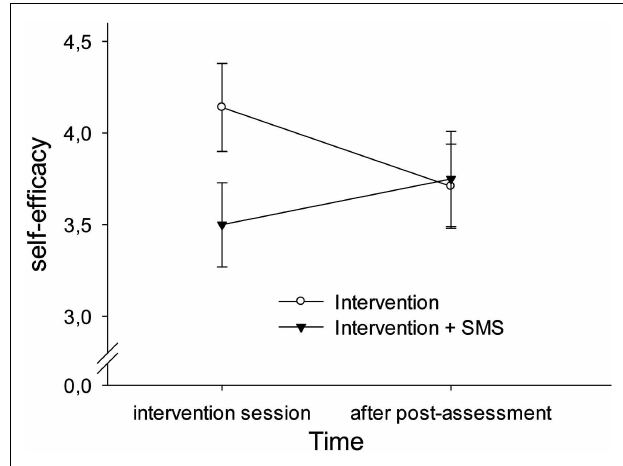
FIGURE 2 | Interaction of group and time on self-efficacy. The augmented intervention group (with text messages) showed an increase in self-efficacy ratings after post-assessment (week 2), whereas the standard intervention group showed a decline. However, both groups marginally differed immediately after the intervention session with the augmented intervention group showing lower ratings than the standard intervention group.Whiskers indicate ± 1 standard